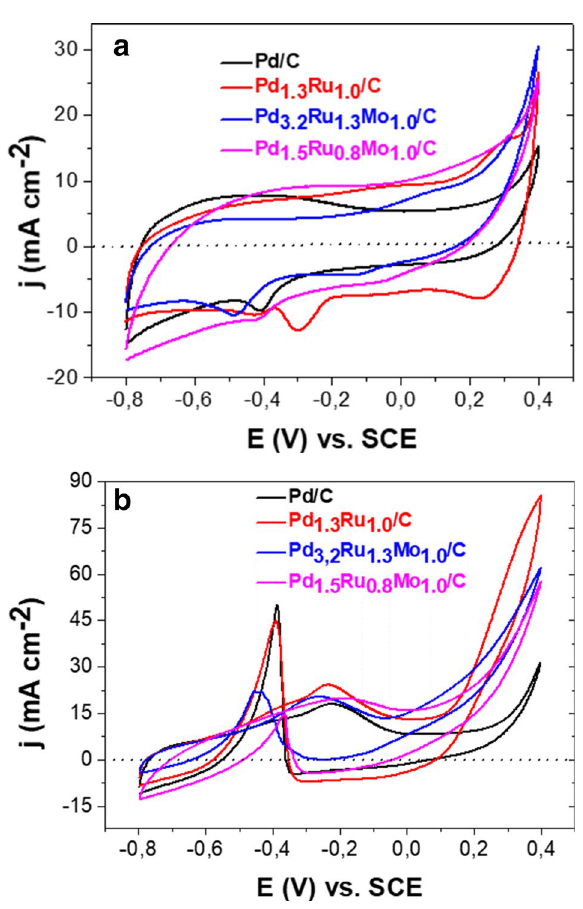
Fig. 4 Cyclic voltammograms of the catalysts in different electrolytes